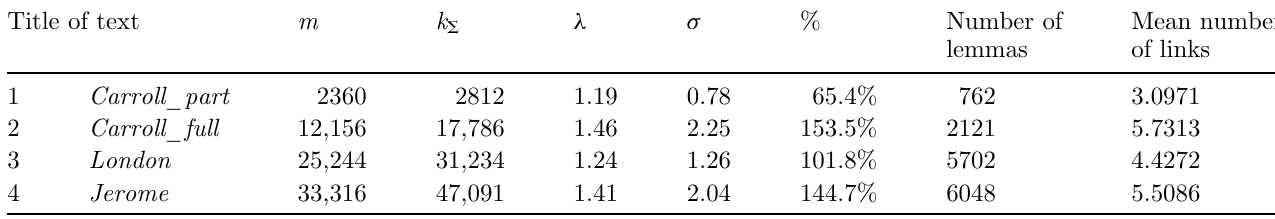
Table 1. Principal results of processing the 4 English-language texts.